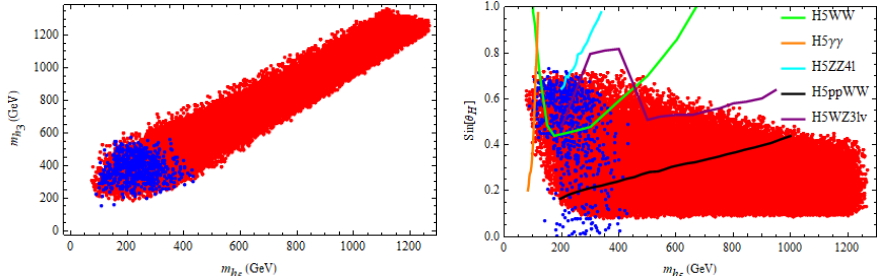
Figure 6 . Left: the v C =T C > 1 viable points in the plane of m h two-step (blue) phase transitions; right: the v C =T C > 1 viable points in the plane of sin (cid:18) H (cid:0) m h for one-step (red) and two-step (blue) phase transition with the upper limits of sin (cid:18) H from di(cid:11)erent